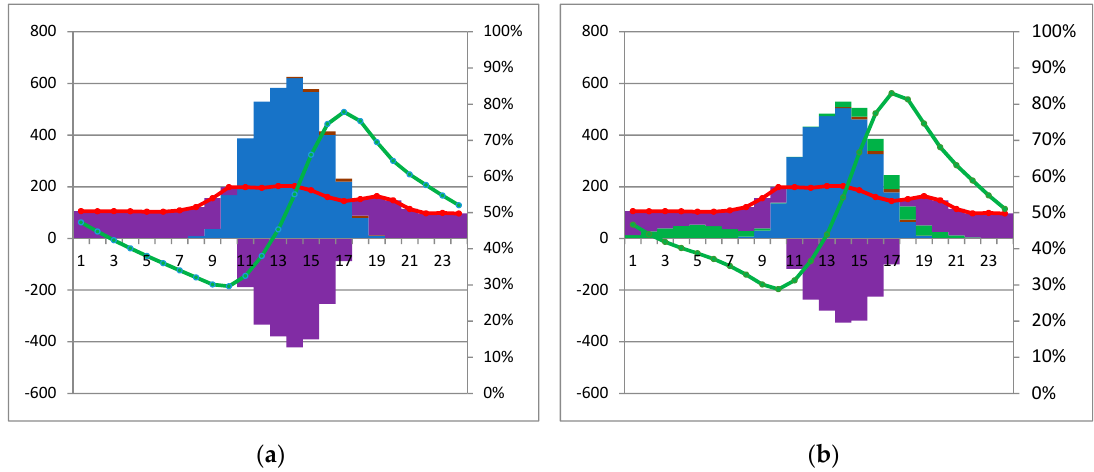
Figure 8. Day 4, 16 / 10 / 2009: Energy balance ( a ) without and ( b ) with tidal energy.